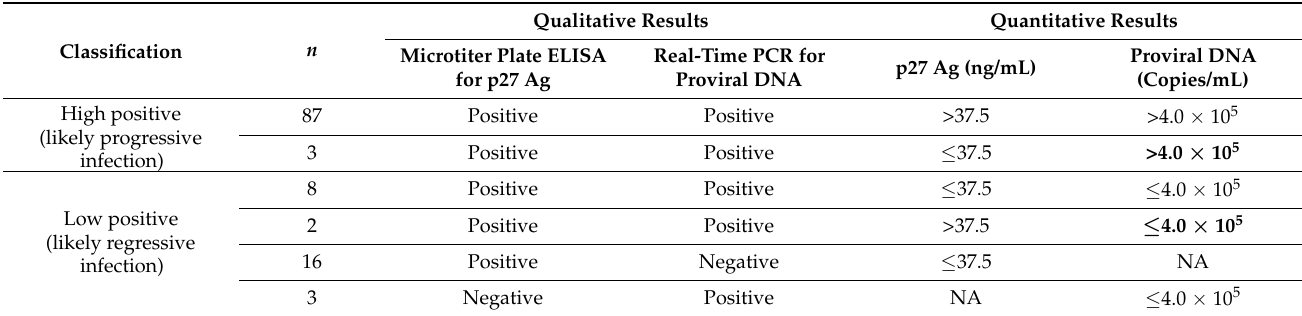
Table 2. Classification of 119 cats in the FeLV-positive group at the time of enrollment using the cutoff values determined from the ROC analysis. When the qualitative results for a sample were positive for both assays but quantitative values were not both above or not both below the respective cutoffs, the quantitative result for proviral DNA (boldface) was used for classification.